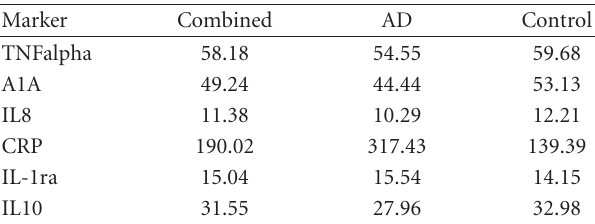
Table 1: Coe ffi cient of variation by